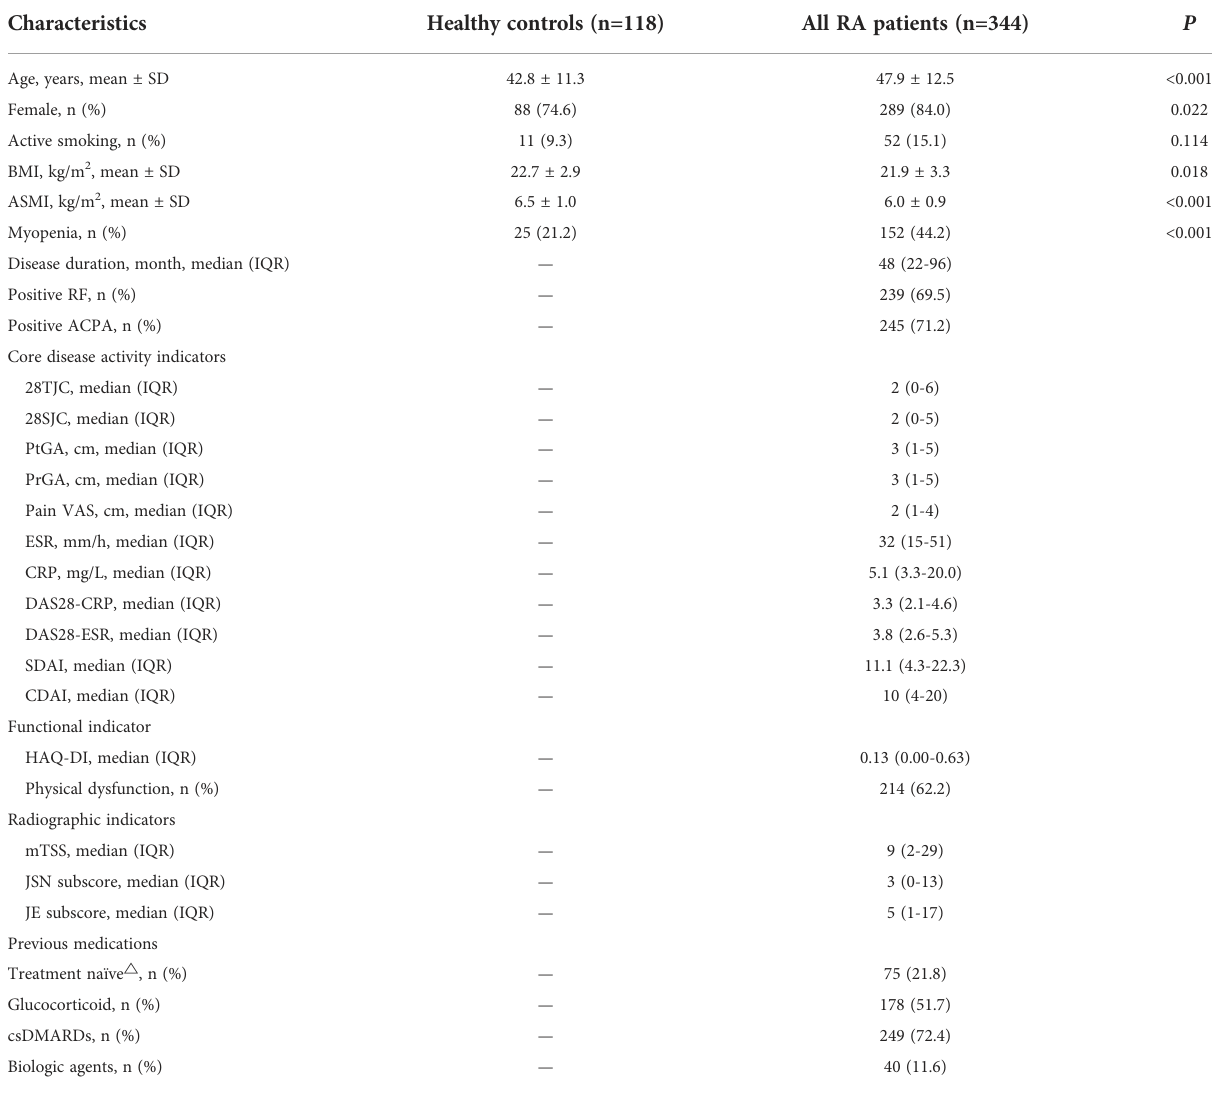
TABLE 1 Baseline characteristics of RA patients and healthy controls.